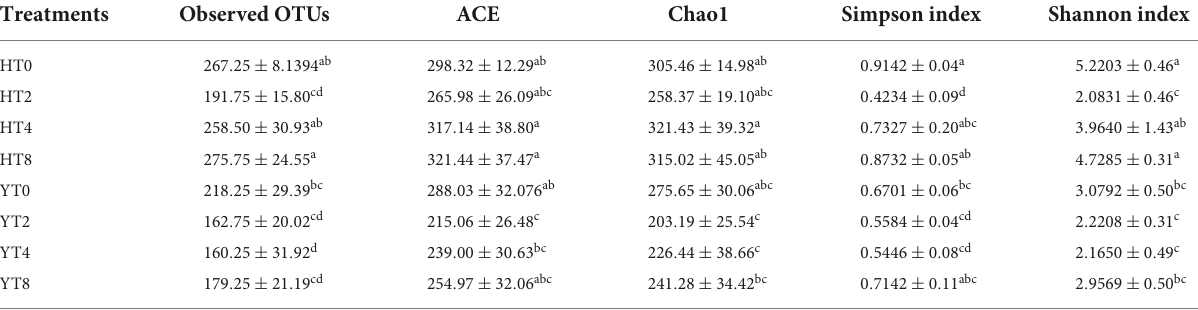
depth was enough for diversity analysis ( Supplementary Figure 2A ). Further, the rank abundance curve revealed the uniform distribution of fungal communities in each sample ( Supplementary Figure 2B ). The alpha diversity matrices (ACE, Chao1, Simpson index, and Shannon index) revealed significant ( p < 0.05) differences in the diversity of fungal communities between rhizosphere of both varieties (H and Y) ( Table 3 ). Overall, the rhizosphere of susceptible variety (H) had higher values of alpha diversity indices and more significant differences in fungal communities from HT0 to HT8 than the Y rhizospheres (YT0 to